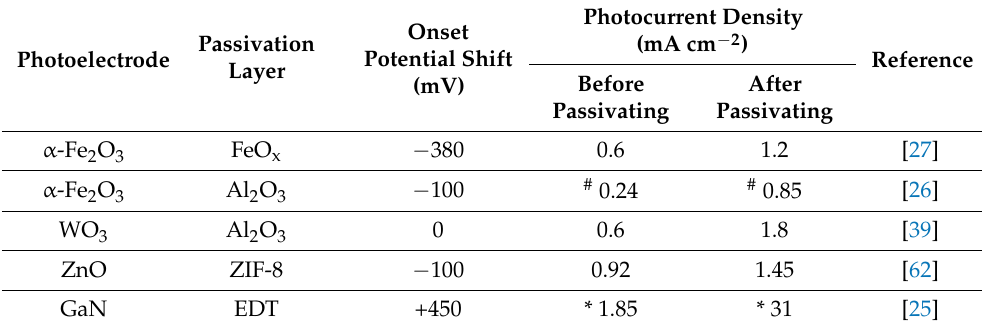
Table 1. Optimized PEC performances of the representative photoelectrodes with surface